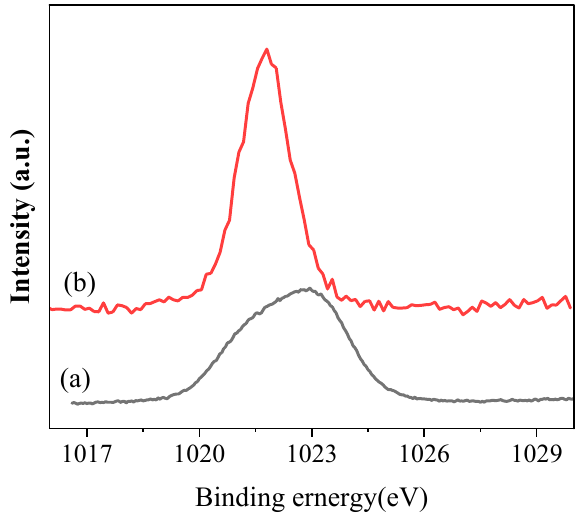
Figure 2. XPS spectra of Zn 2p 3 /2 for ( a ) ZnCl 2 and ( b ) Zn(Acac) 2 .